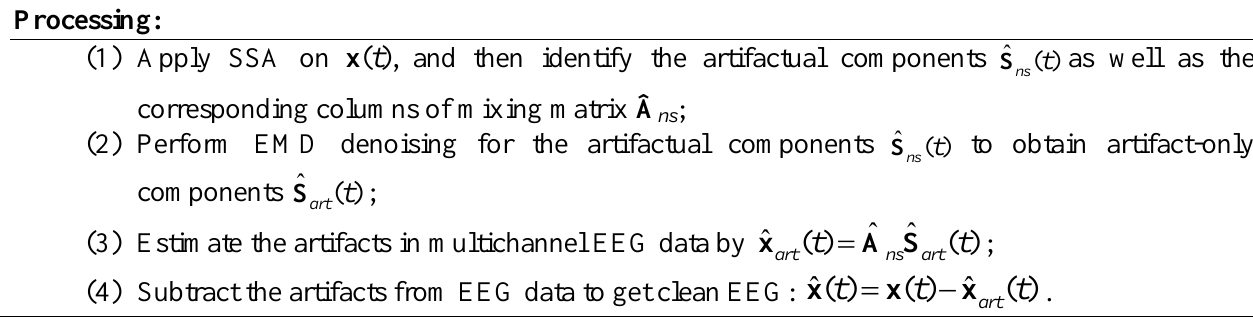
Table 1. Summary of proposed approach for EOG artifacts correction from raw EEG recordings.